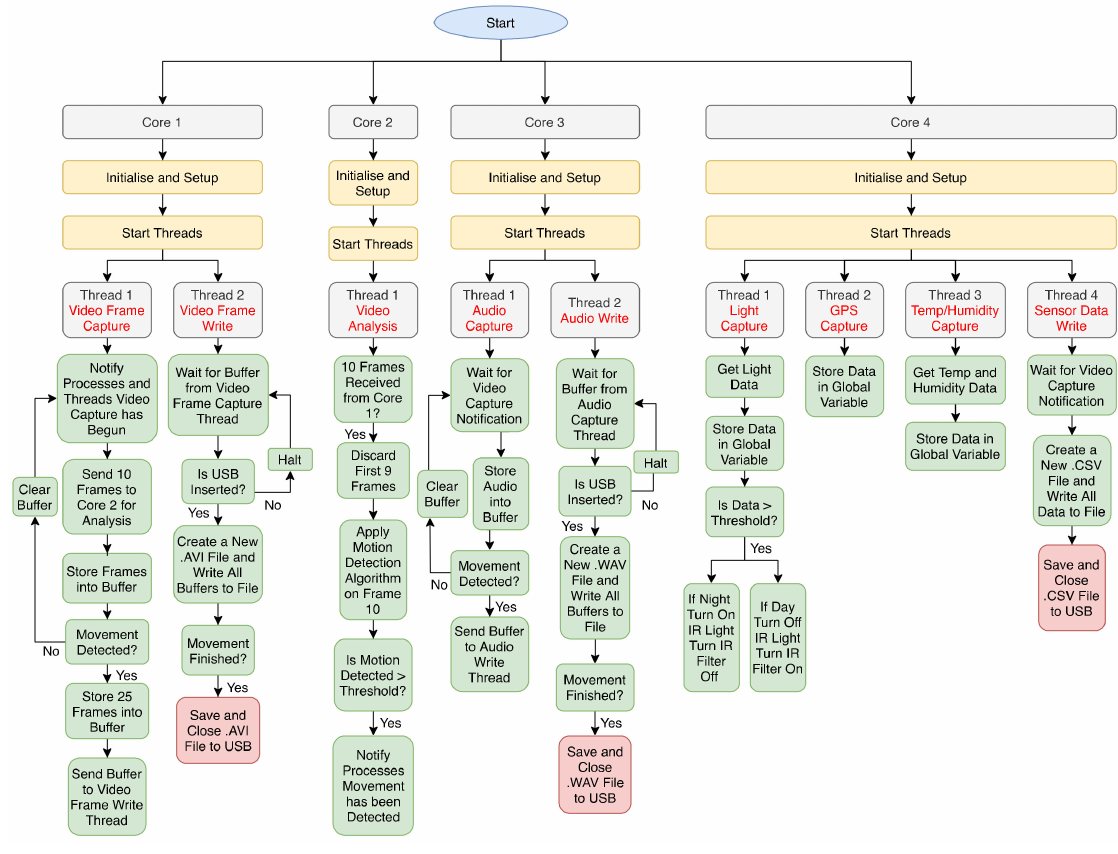
Figure 3. Software operation flowchart.